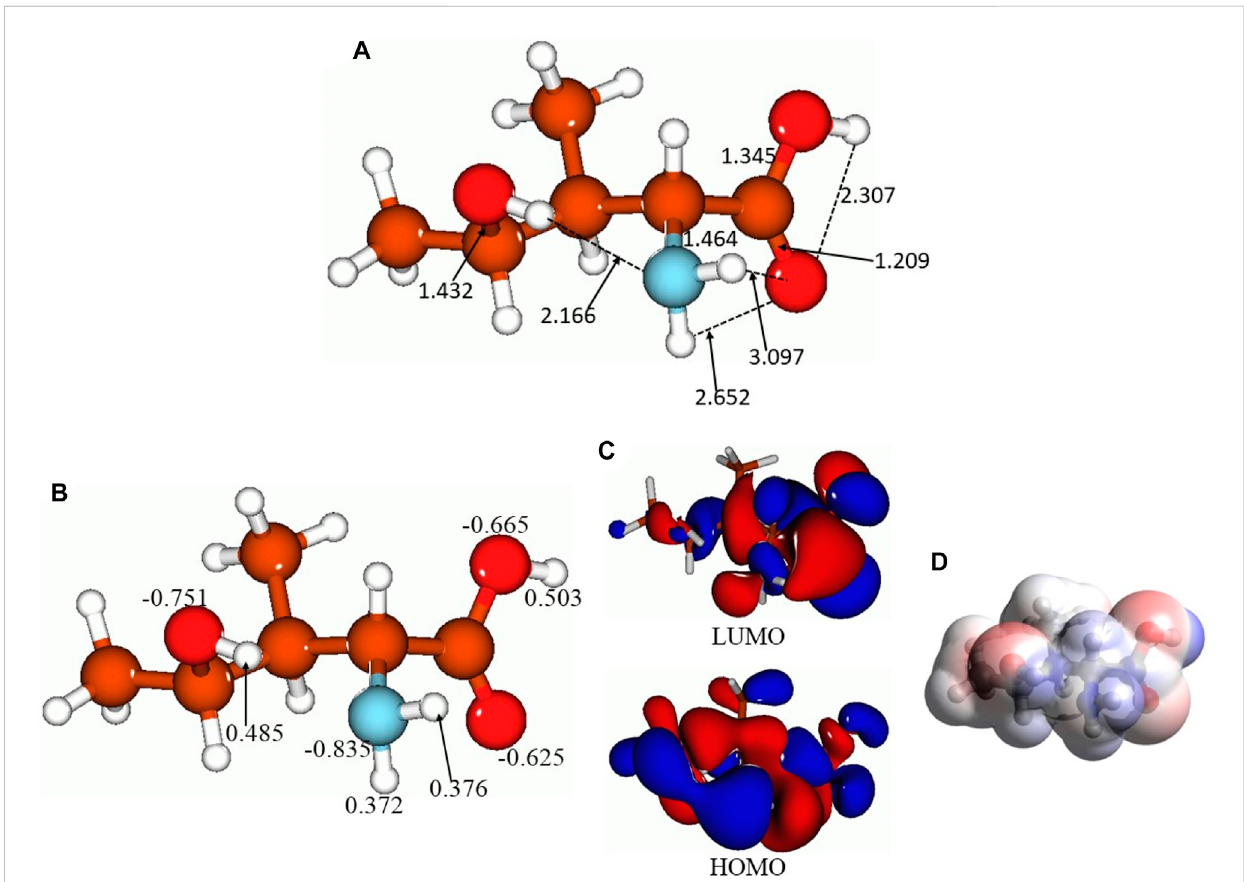
FIGURE 4 Lowest-lying isomer 5 of 4-hydroxyisoleucine: selected bond distances, Å (A) , NBO charges on the selected atoms (B) , FMOs (C) , and MEP plot (D) .